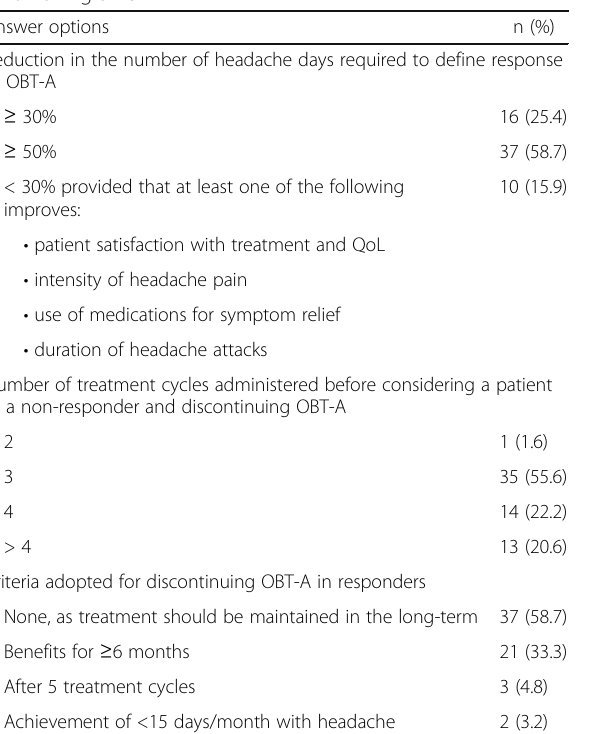
Table 3 Onabotulinumtoxin A (OBT-A) in the context of other prophylactic therapies for chronic migraine and timing of OBT-A